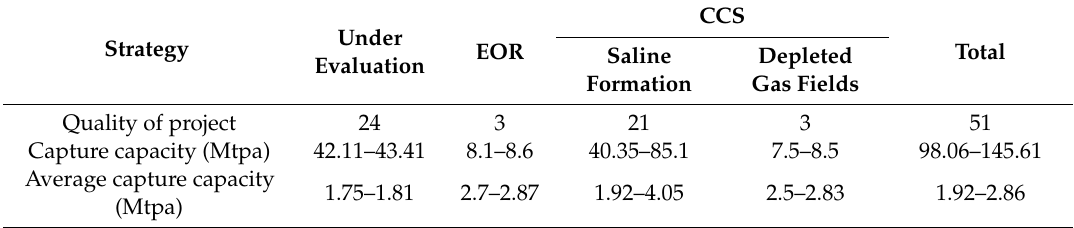
Table 7. Large-scale CCS projects (more than 0.4 Mtpa) from 1972 to the end of the 2020s (data from